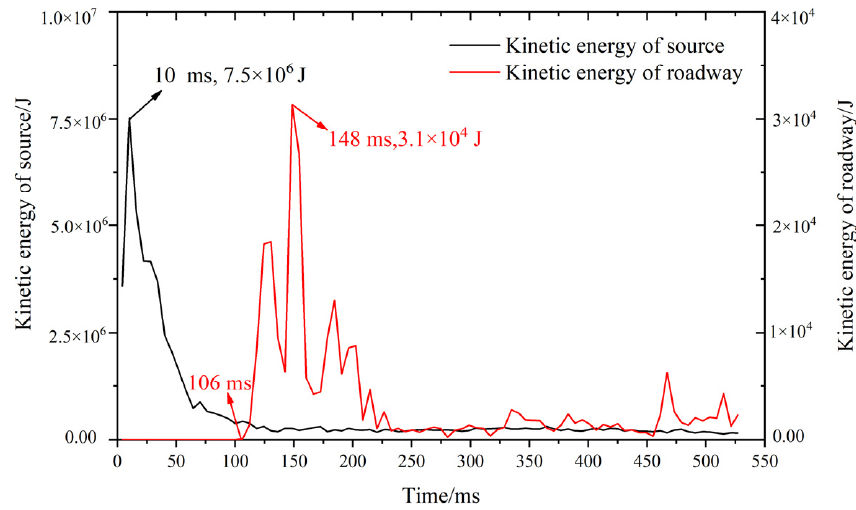
Figure 5. Kinetic energy curves of roadway and source after mining ‐ induced tremor.